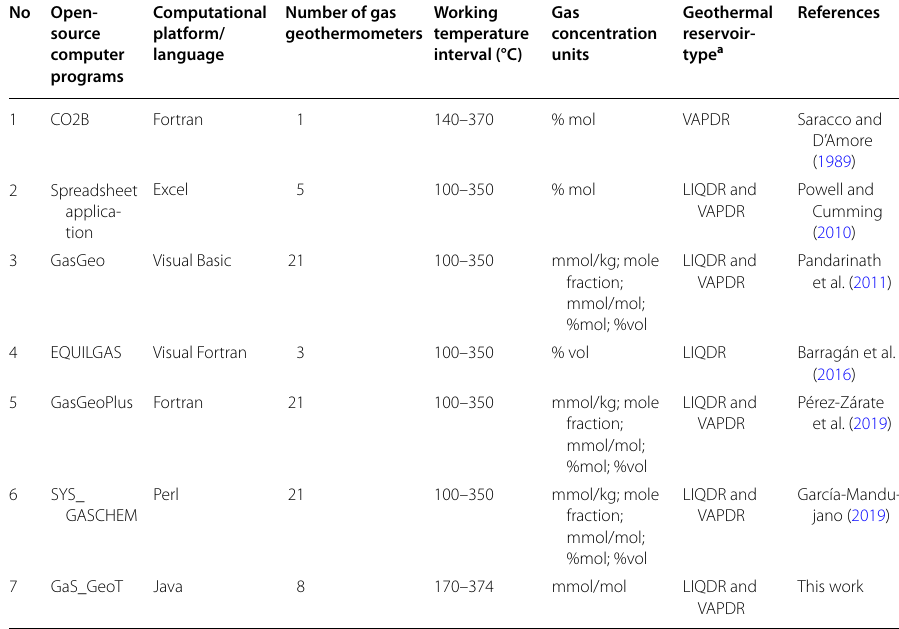
a Type of geothermal reservoir used to calibrate the gas